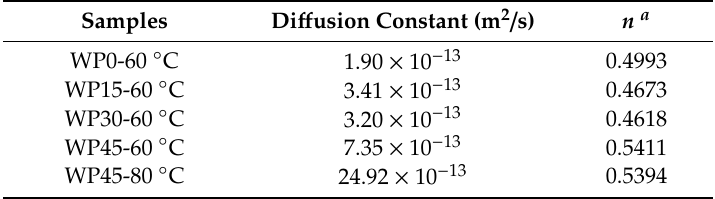
Table 1. Water absorption parameters for wood-filled polypropylene